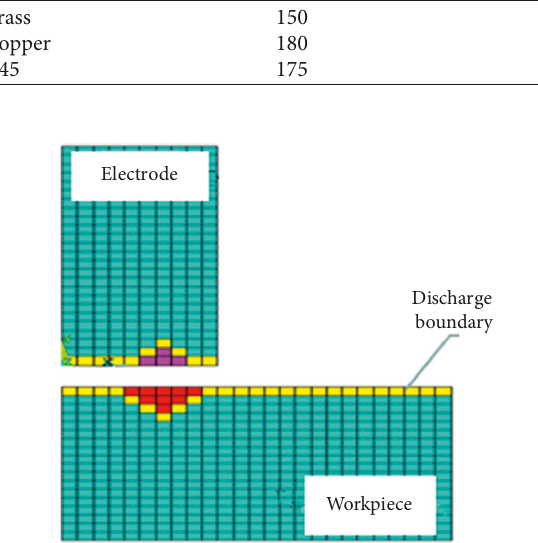
Figure 5: Multimaterial electrode discharge boundary.